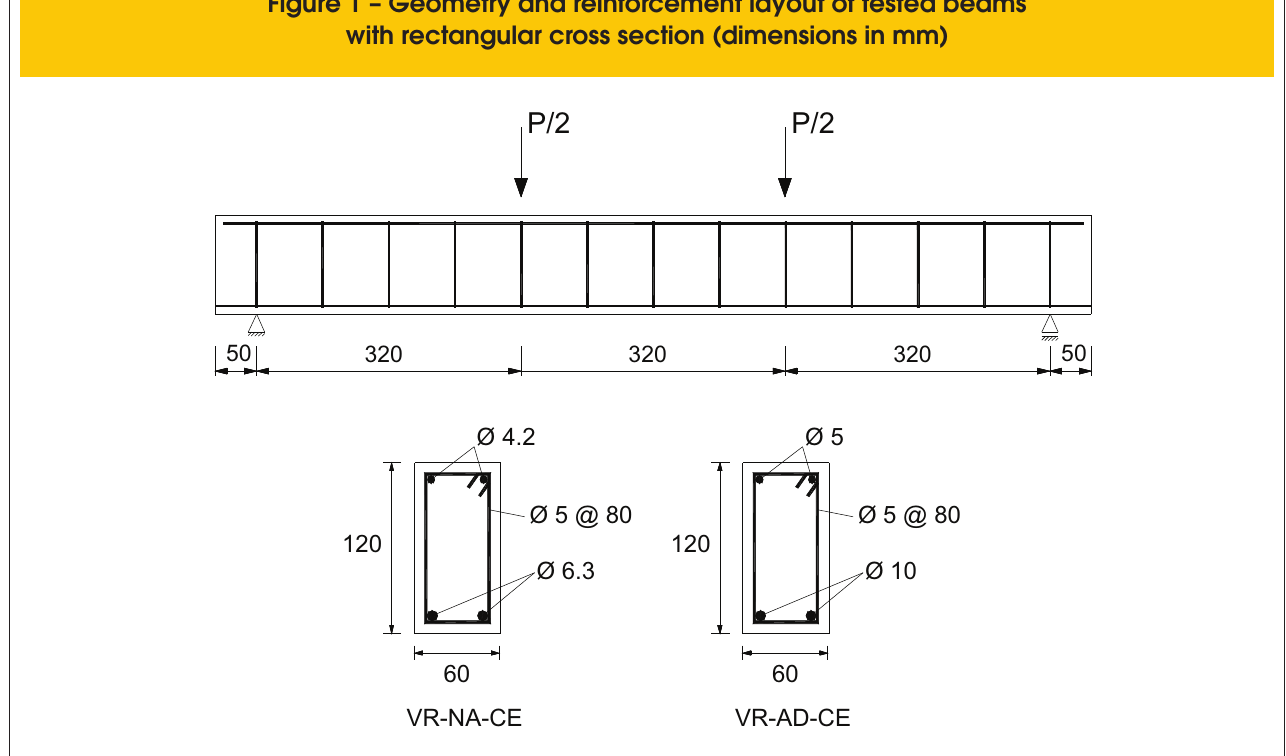
Figure 1 – Geometry and reinforcement layout of tested beams with rectangular cross section (dimensions in